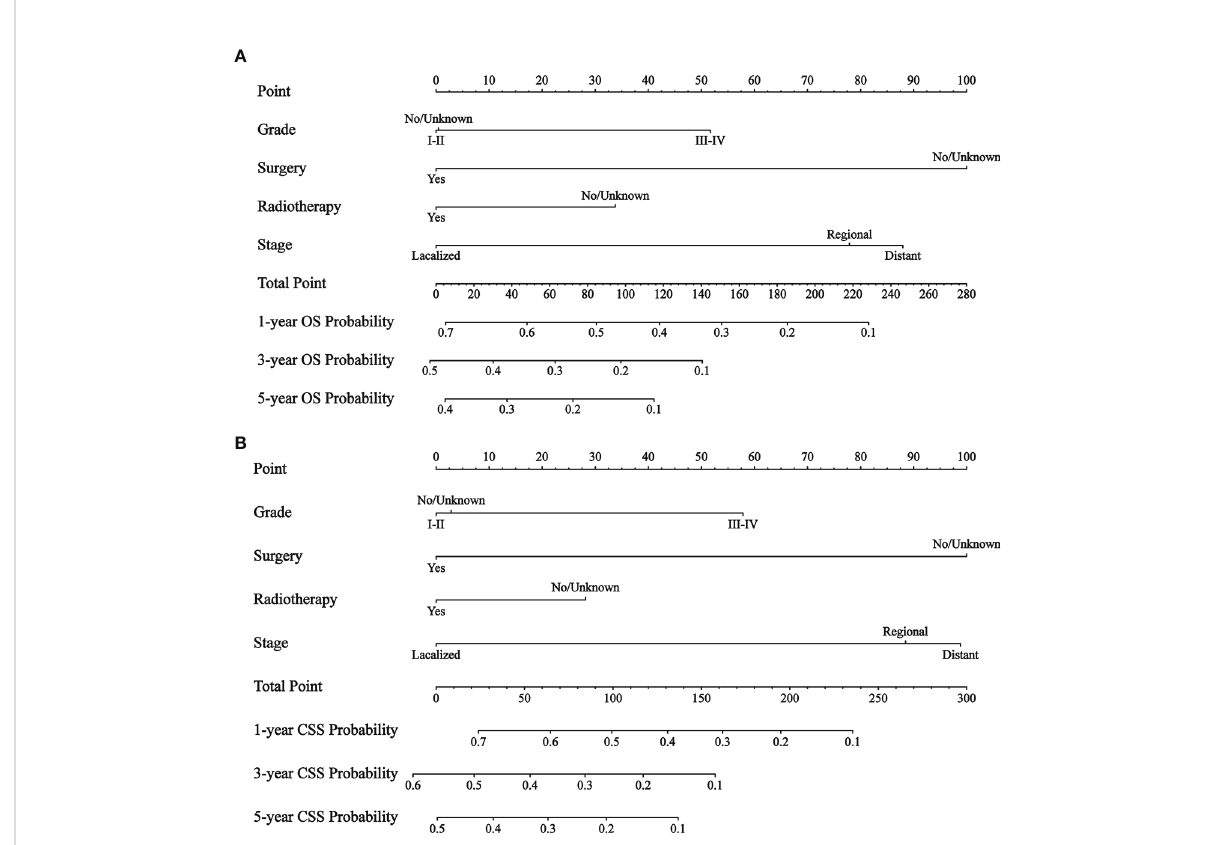
FIGURE 2 The nomograms to predict OS and CSS at 1-, 3-, 5-year for patients with GBMAC. (A) The nomogram to predict OS for patients with GBMAC. (B) The nomogram to predict CSS for patients with